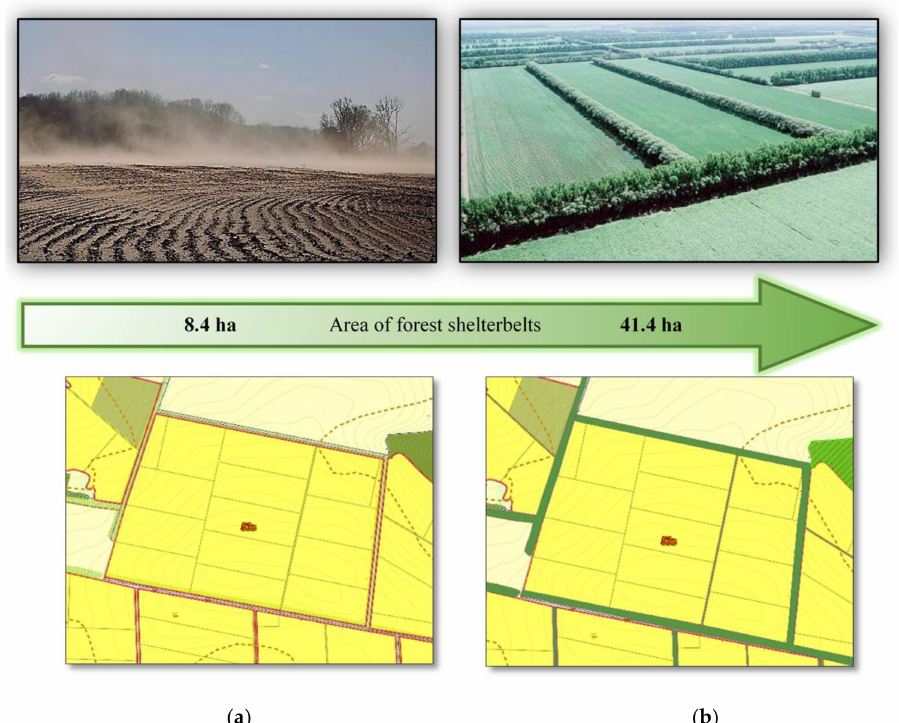
Figure 4. Projecting of forest shelterbelts within the territory of the farming enterprise according to the grass and bioenergy planning scenarios (photo: [47,48]: ( a ) Baseline scenario; ( b ) Land protection and bioenergy production